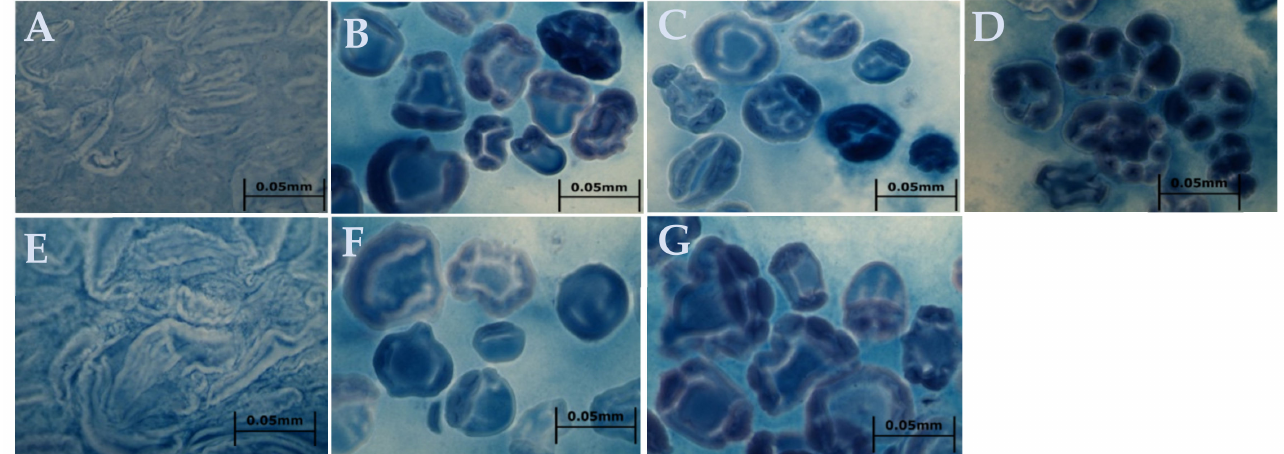
Figure 3. Effect of various hydrothermal treatments on the iodine-staining morphology of water caltrop starch pastes. ( A ) Native starch; ( B ) HMT20; ( C ) HMT25; ( D ) HMT30; ( E ) ANN; ( F ) HMT20 + ANN; ( G ) ANN + HMT20. HMT indicates heat-moisture treatment. The numbers 20, 25, and 30 indicate the moisture level under HMT. ANN indicates